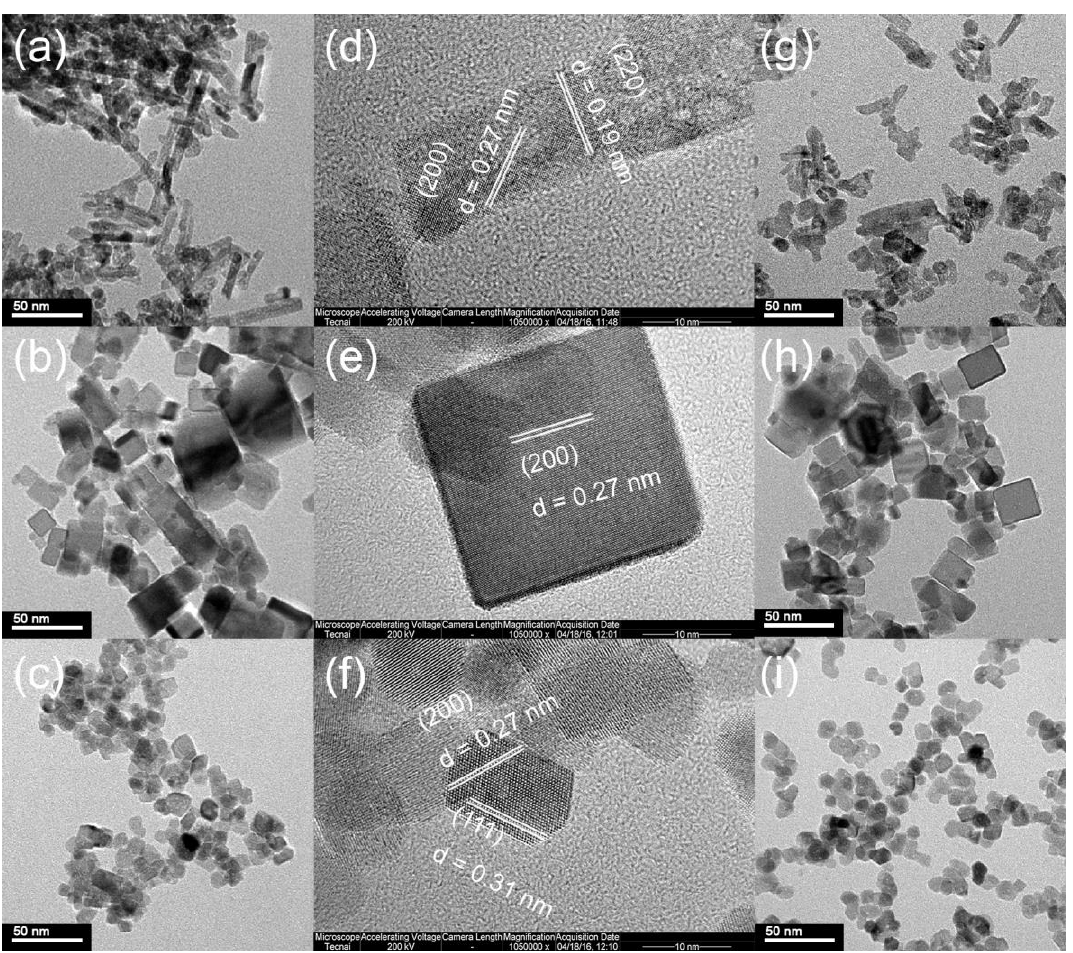
Figure 1. TEM images of ( a ) CeO 2 -NRs, ( b ) CeO 2 -NCs, and ( c ) CeO 2 -NPs; high-resolution transmission electron microscopy (HRTEM) images of ( d ) CeO 2 -NRs, ( e ) CeO 2 -NCs, and ( f ) CeO 2 -NPs; TEM images of ( g ) Ru/CeO 2 -NRs, ( h ) Ru/CeO 2 -NCs, and ( i ) Ru/CeO 2 -NPs.